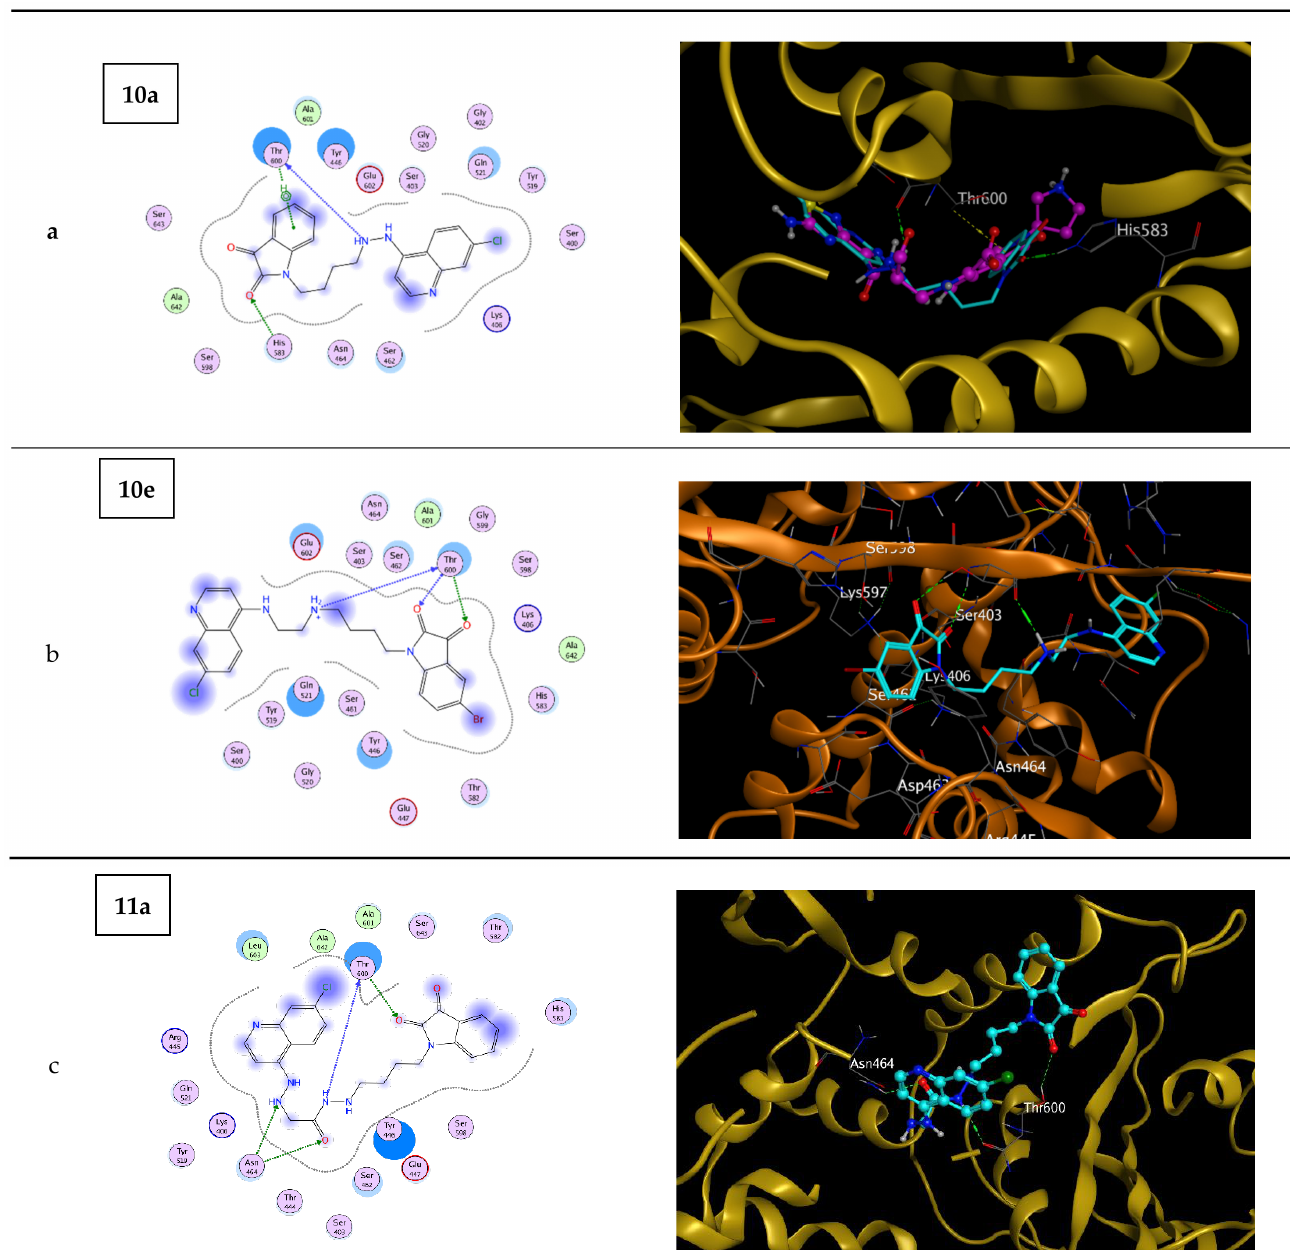
Figure 8. Compound 10a , 10e and 11a interactions inside the active site with H-bonds in green and H-Pi interaction in yellow. ( a ) 10a (in cyan sticks overlapped with the co-crystallized ligand in magenta ball and stick), ( b ) 10e (in cyan sticks), ( c ) 11a (in cyan ball and stick).